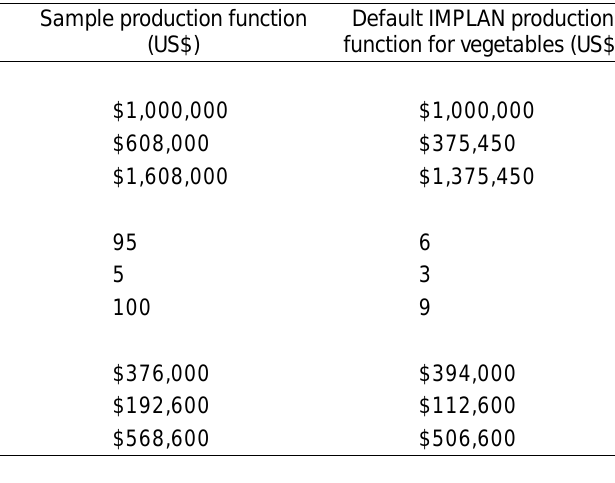
Table 2. Economic Contribution of US$1 Million in Sales, Sample Operations versus Default IMPLAN Production Function, in the 13-county